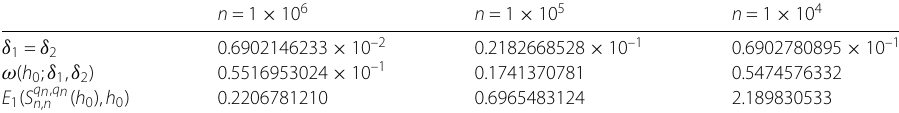
Table 1 The approximation error of S q n , q n n , n ( h 0 ) to h 0 by means of the complete modulus of continuity